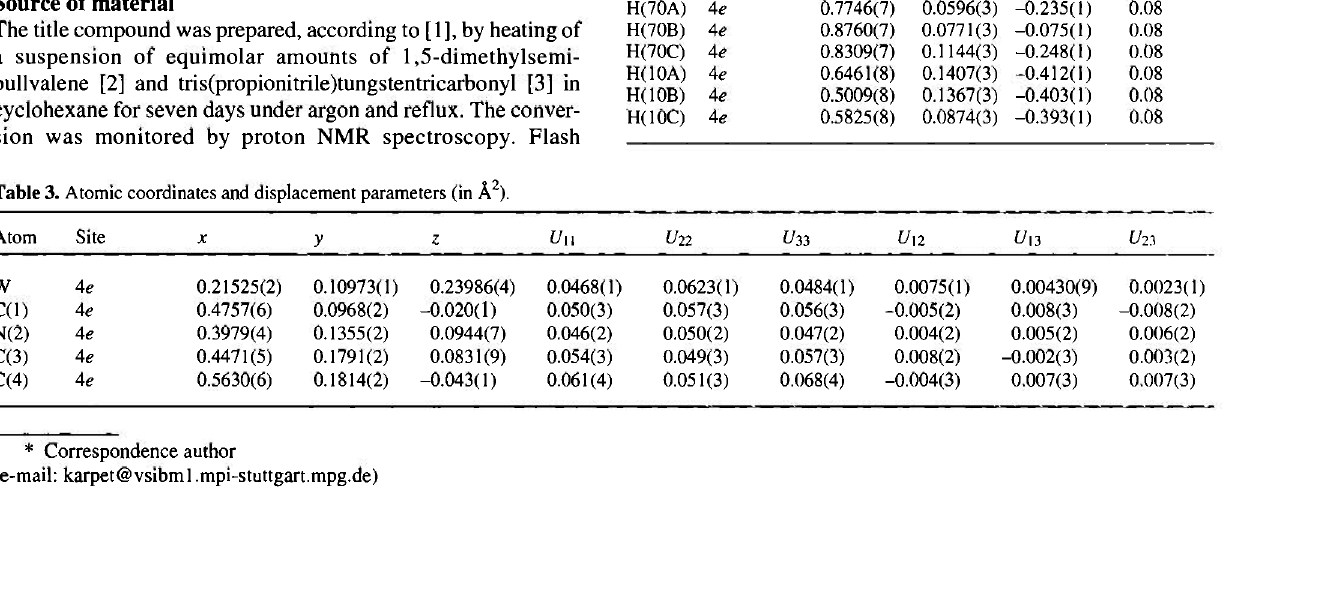
Table 2. Atomic coordinates and displacement parameters (in